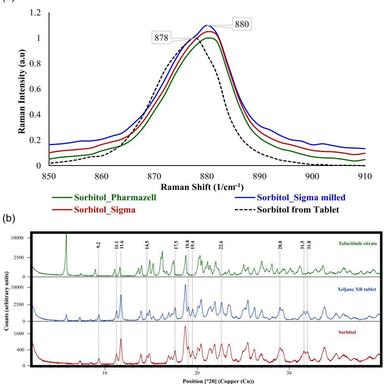
(A) Comparison of sorbitol Raman spectra from "As Received" and "Tablet". (B). Comparison of PXRD diffractograms of Xeljanz tablet, Tofacitinib Citrate API, and Sorbitol.